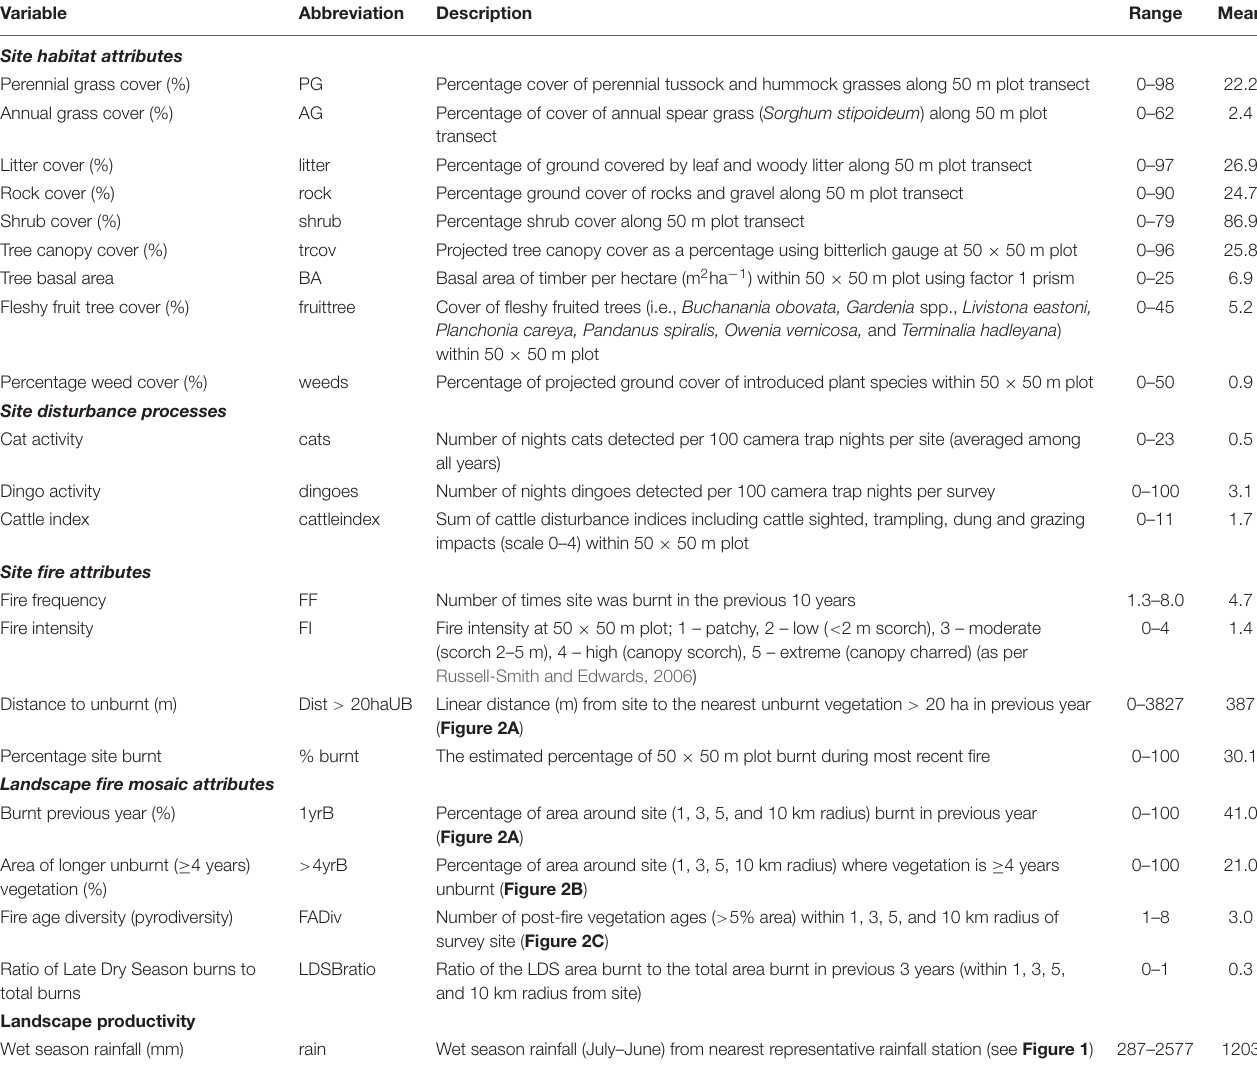
TABLE 2 | Explanatory variables measured at and around survey sites, their definitions and summary